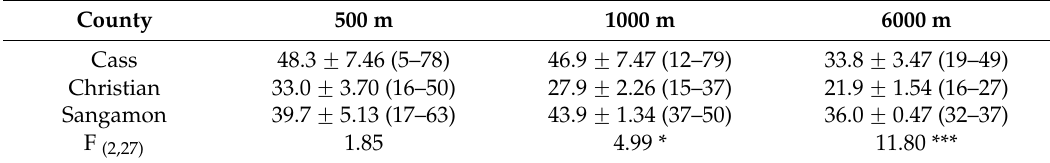
Table 1. Average ˘ standard error (se) of complexity for each of the three counties expressed as the percentage non-agricultural area of the area in a radius of 500, 1000, and 6000 m around the sampling location. Minimum and maximum percentages are between brackets. Results of the F -test on the difference between counties are given on the bottom line; * p < 0.05; *** p < 0.001. Results of Tukey HSD are given in Table